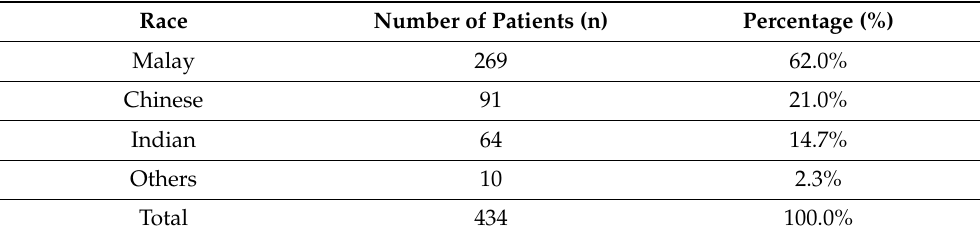
Table 1. Distribution of DFI patients by race.